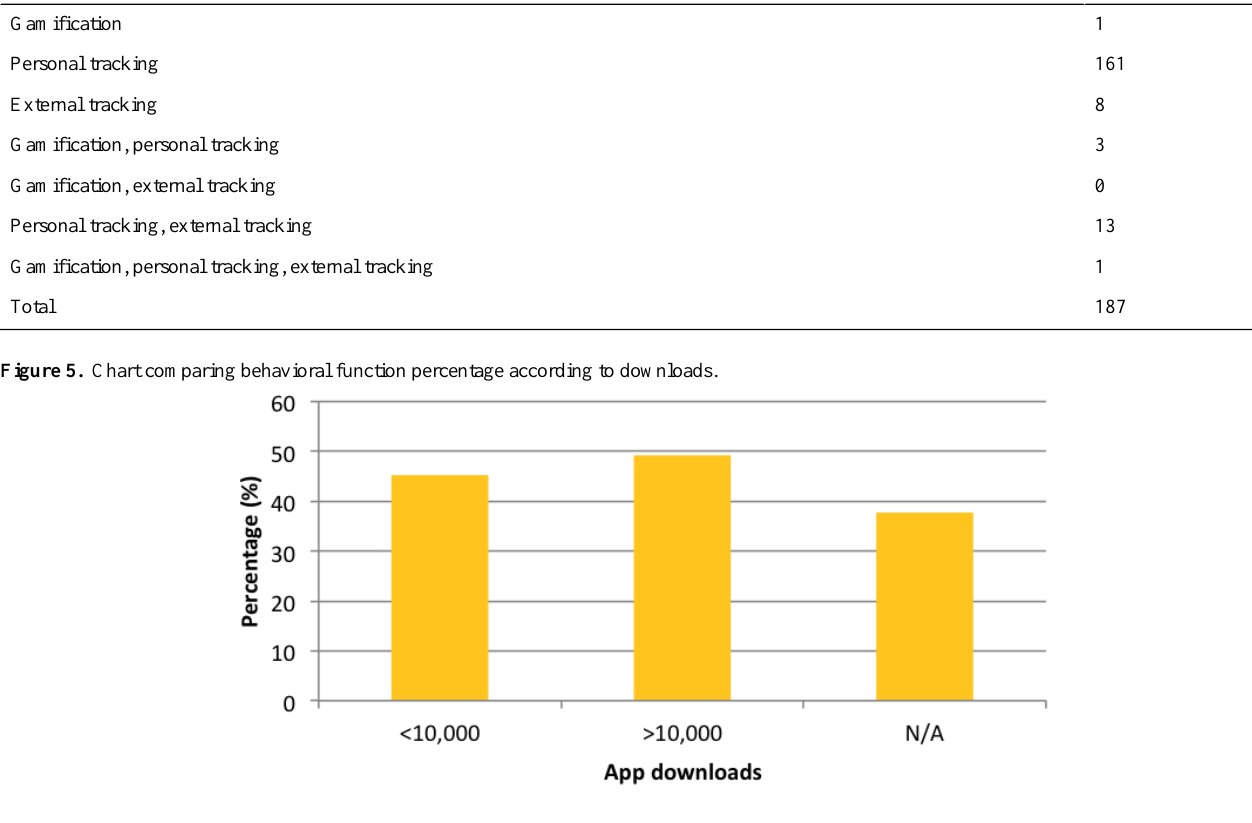
Figure 6. Chart comparing behavioral method percentage among apps in different app